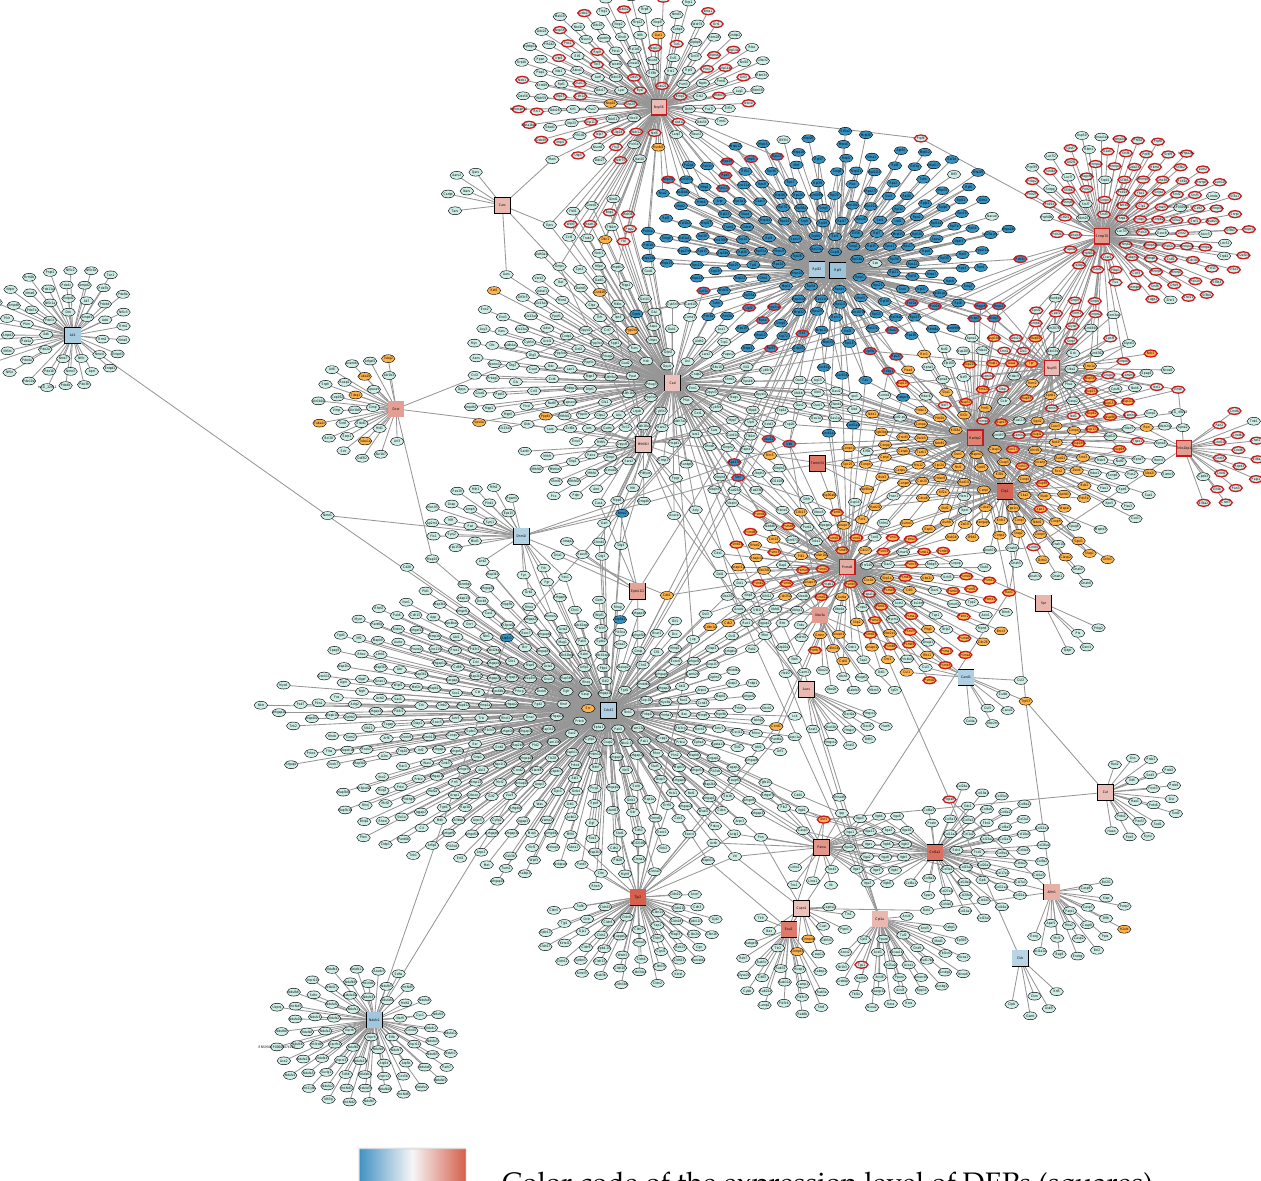
Color code of the expression level of DEPs (squares) −2.85 Figure 1. Subnetwork 1 of DEPs and their protein interaction partners after 24 h exposure to 95% O 2 . Differentially expressed proteins (seed proteins of the network) are shown as squares, with the fill color corresponding to the expression level (blue: downregulated; red: upregulated; the intensity of the color represents the degree of down- or upregulation as indicated in the legend). Interacting proteins not belonging to the seed protein list are shown as ellipses. Primary enriched pathways and functions with FDR < 0.05 are highlighted: Upregulated: cell cycle (orange), metabolism of RNA and RNA splicing (red borders), Downregulated: ribosomes (dark